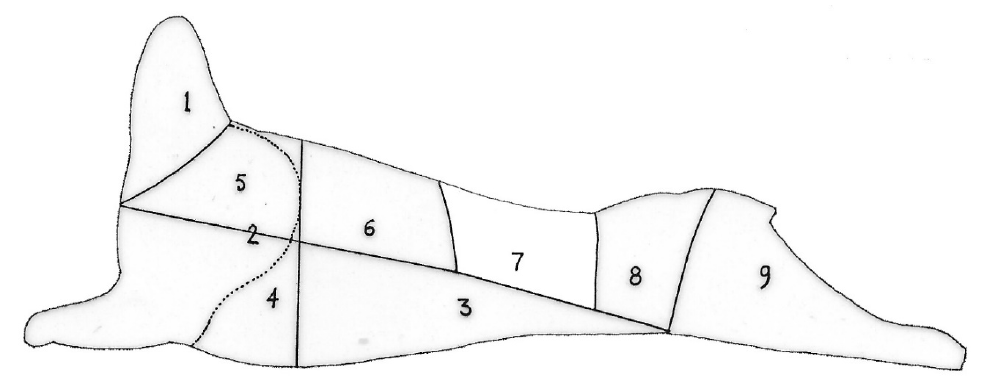
Figure 2. Dissection diagram representing goat carcass composition. 1—neck (cranial end); 2—thick rib; 3—flank (abdominal muscles); 4—shoulder; 5—breast; 6—lower rib; 7—loin; 8—chump; 9—leg and shin (caudal end) [20].